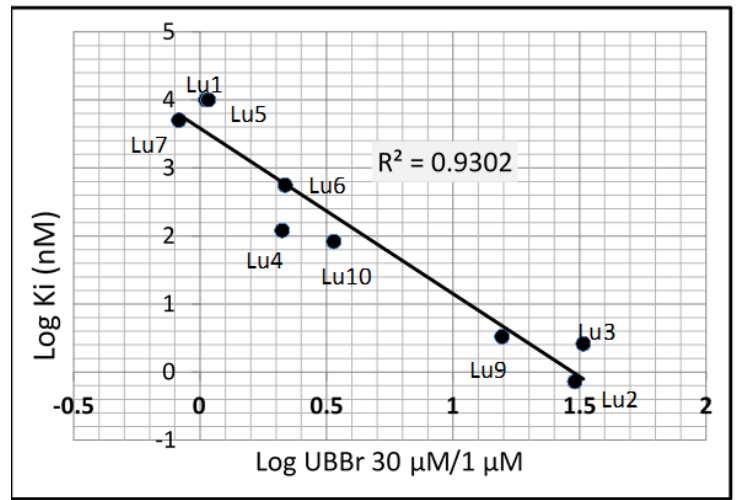
Figure 1. Correlation between change in brain tissue binding and affinity for HSP90. Correlation between shift in brain tissue binding (expressed as ratios of unbound fractions at 30 µM over fractions determined at 1 µM) and affinity for HSP90.